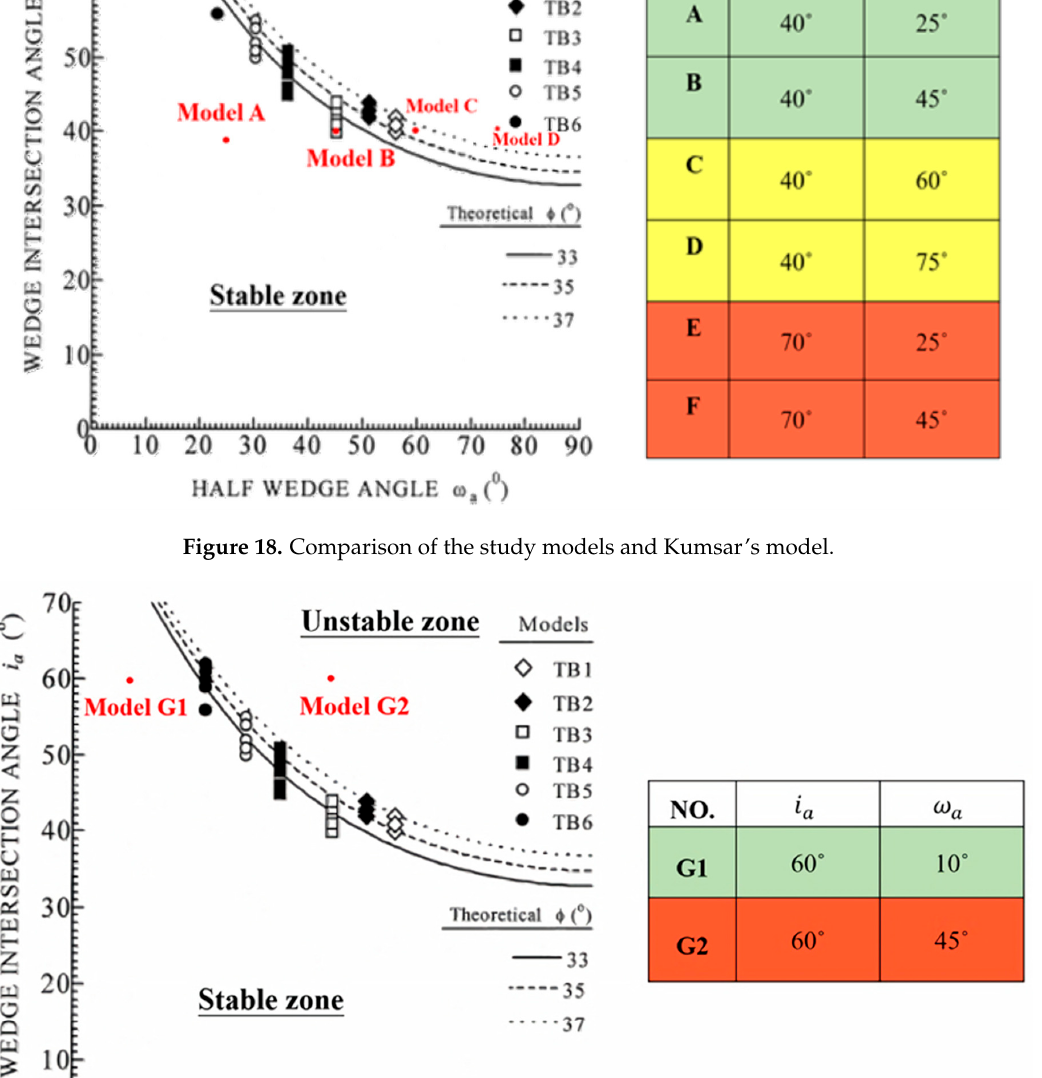
Figure 19. Comparison of the eccentric model and Kumsar’s model.